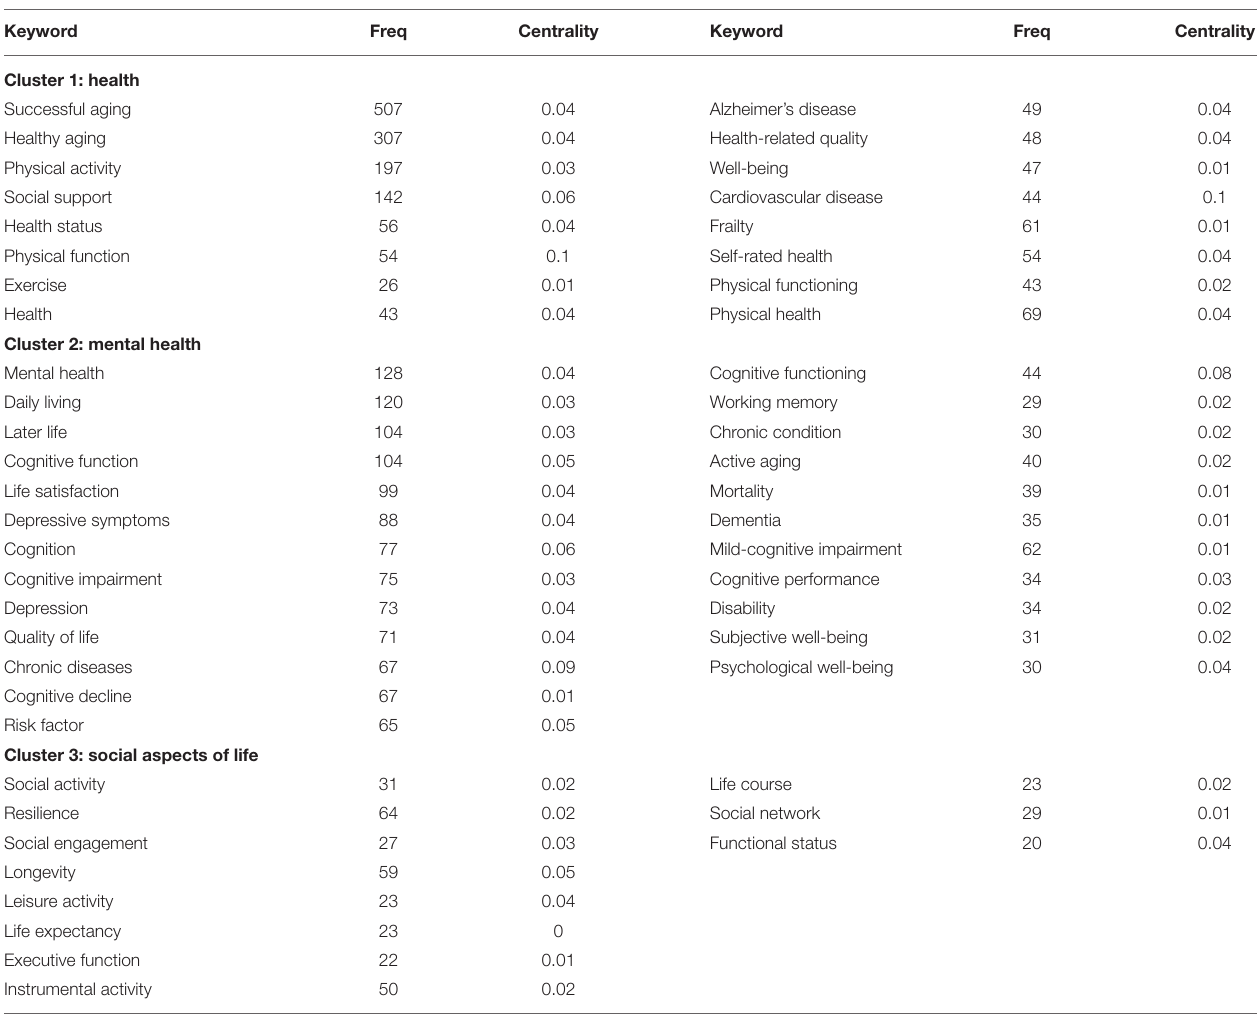
TABLE 2 | Successful aging and healthy